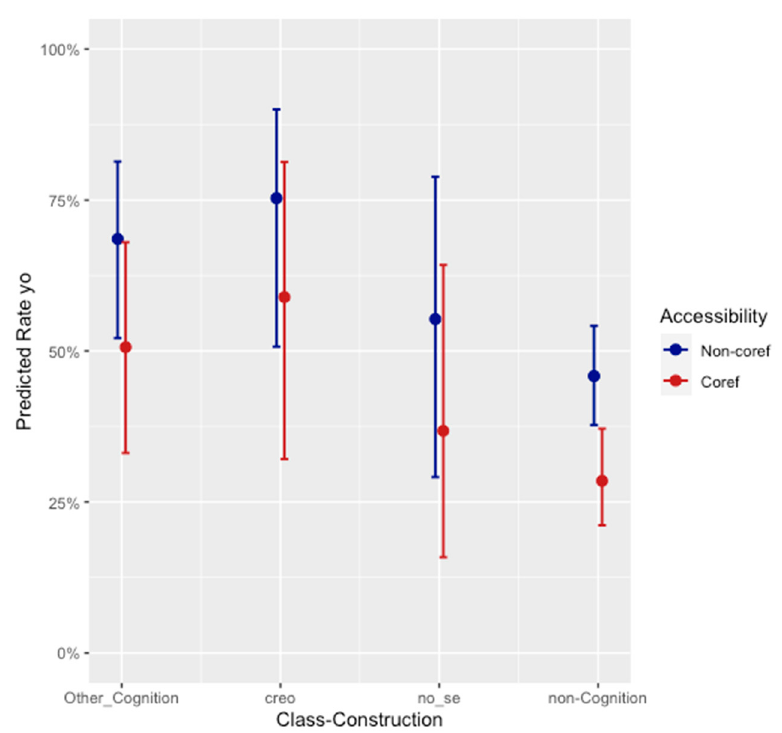
Figure 5. Predicted rate of subject expression for construction by accessibility, from model presented in Table 2. Pronominal subjects are favored in non-coreferential contexts for cognition verbs, for the lexically particular constructions ( yo) creo and ( yo) no sé , and for non-cognition verbs.